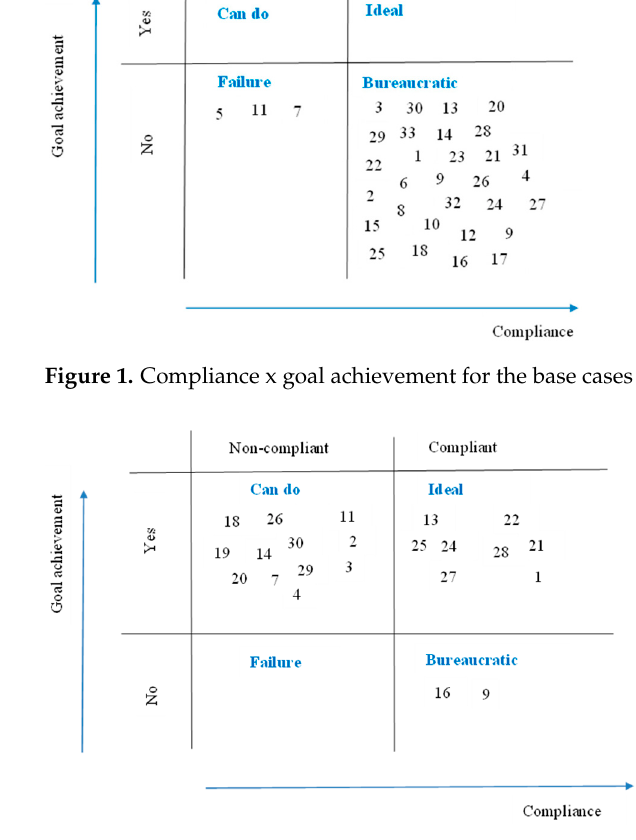
Figure 2. Compliance x goal achievement for local ingenuity (N = 22).